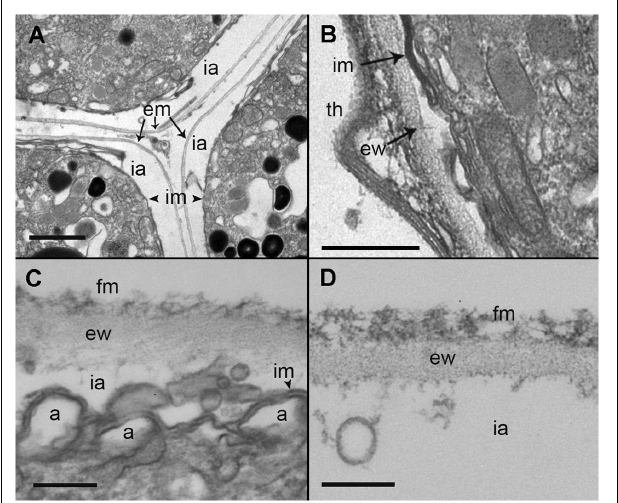
FIGURE 7 | Transmission electron microscopy (TEM) micrographs showing the different stages in the development of Maranthos nigrum membranes. (A) External structure of three trophont membranes growing in contact. (B) Membrane structures from an early sporont. (C) Detail of the membrane from an early sporont, showing the folded parasitoid inner membrane with the external wall completely formed. (D) External wall structure after retraction of the sporont cytoplasm. Abbreviations: a = alveoli; em = external membrane; ew = external wall; fm = fibrous material; ia = intermediate area; im = inner